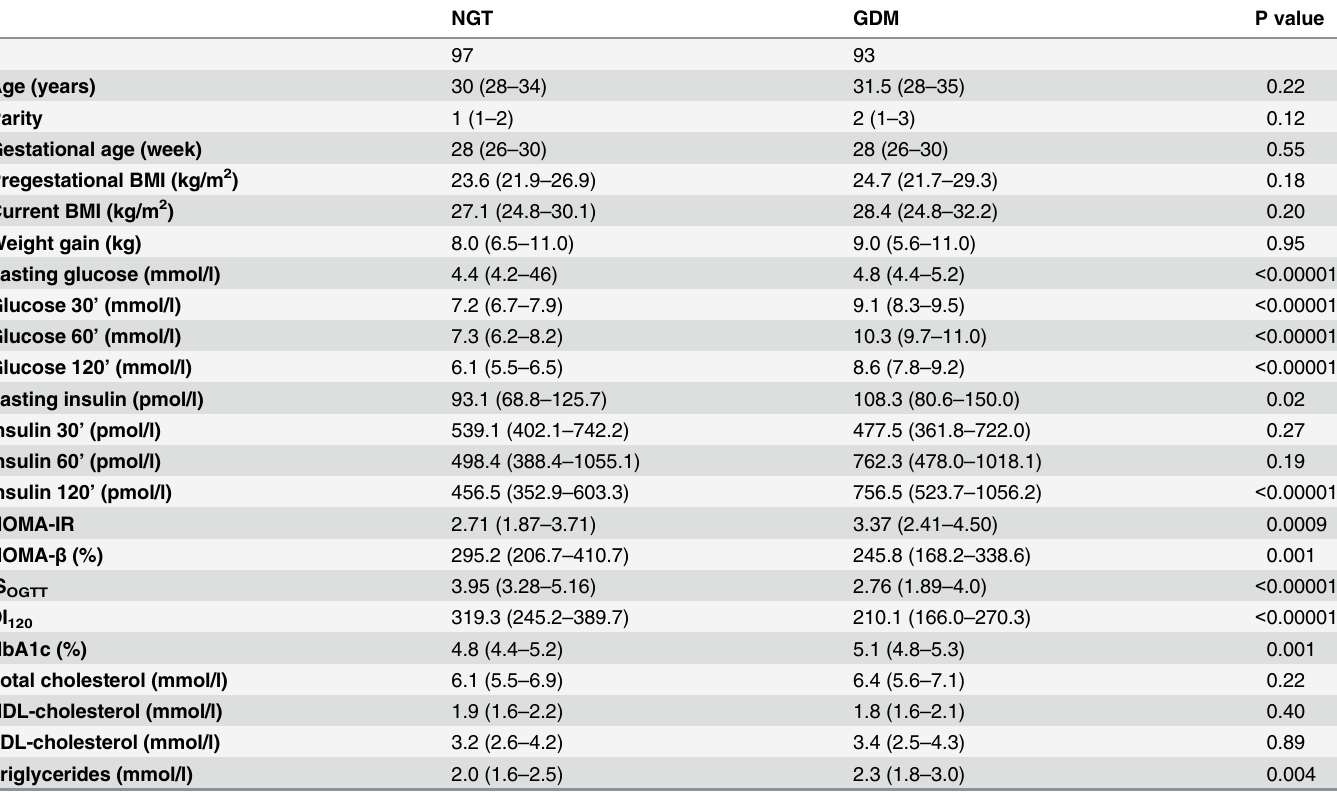
Table 1. Clinical characteristics of Group 1 during